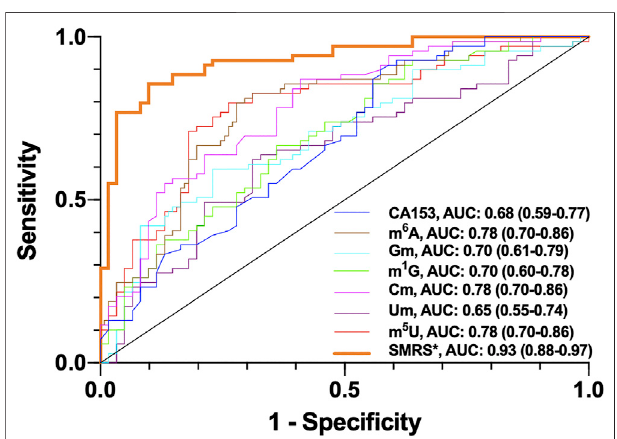
FIGURE5| ROCanalysisform 6 A,Gm,m 1 G,Cm, Um,m 5 U,SMRSand CA153 in serum samples of breast cancer patients. *SMRS: serum monomethylated ribonucleosides